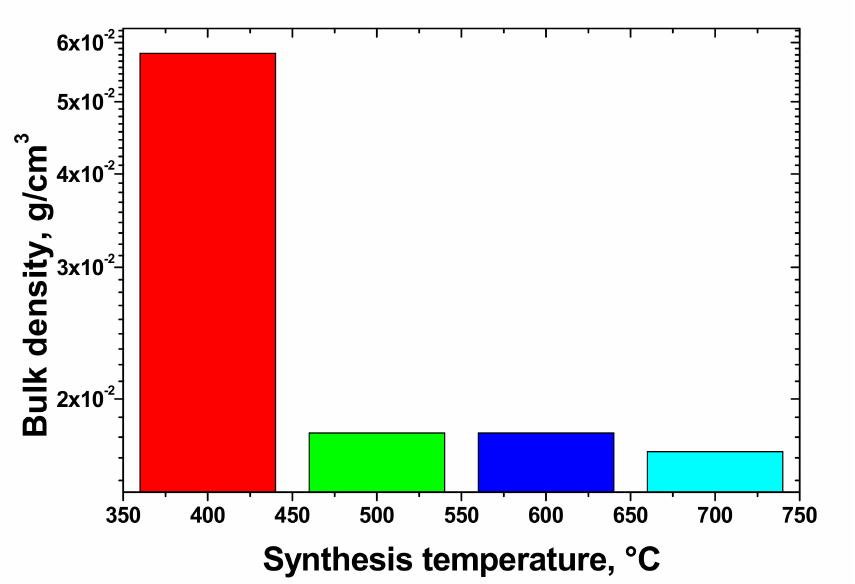
Figure 4. Dependence of bulk density of EG, synthesized by programmable heating, on the synthe- sis